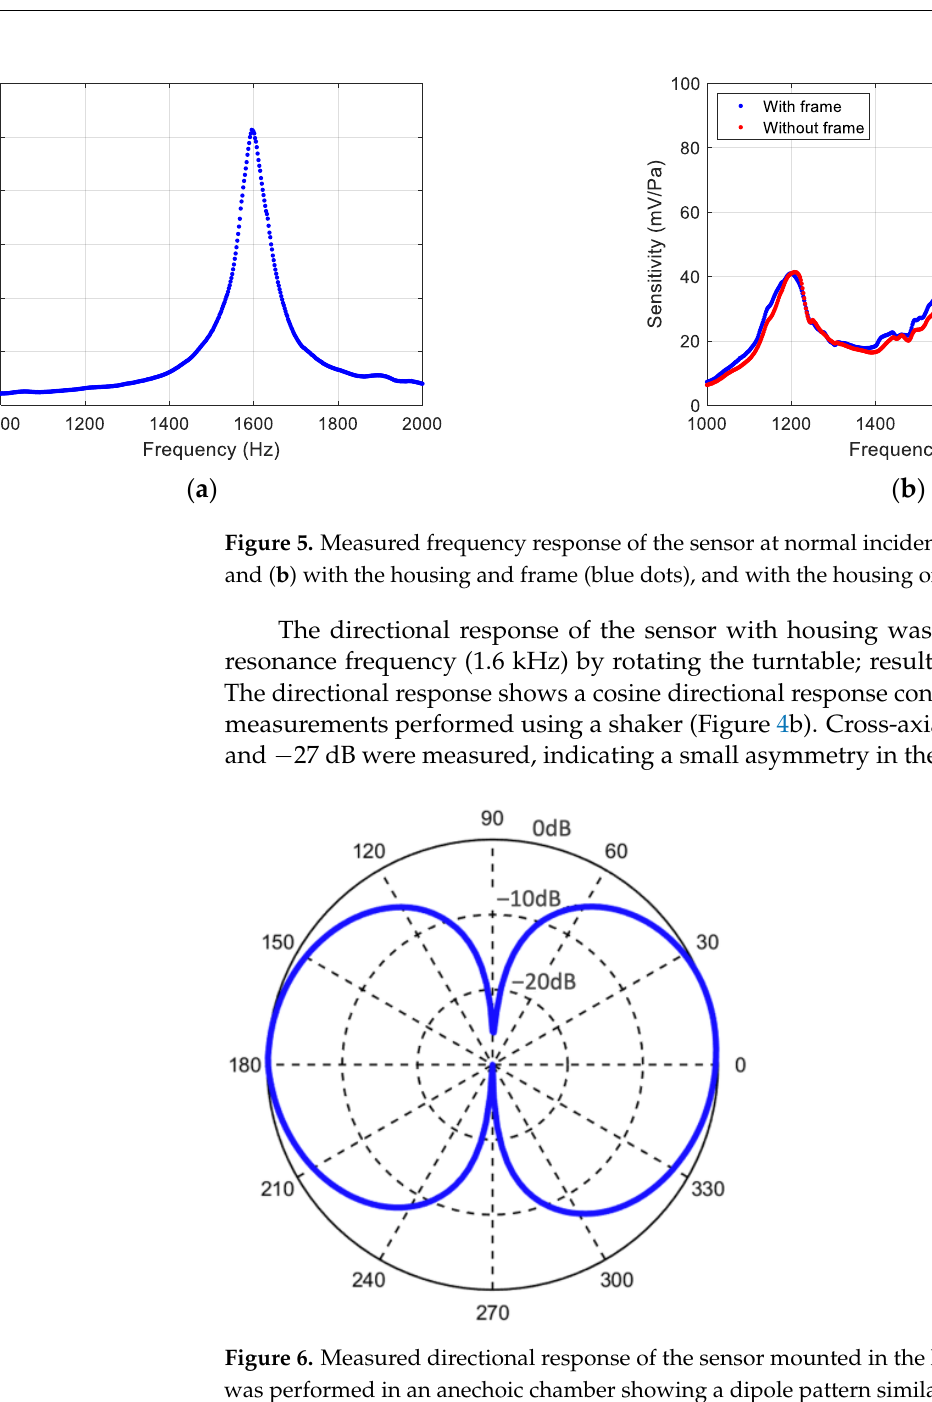
Figure 6. Measured directional response of the sensor mounted in the housing. The measurement was performed in an anechoic chamber showing a dipole pattern similar to that obtained using the shaker table measurement (Figure 4b)